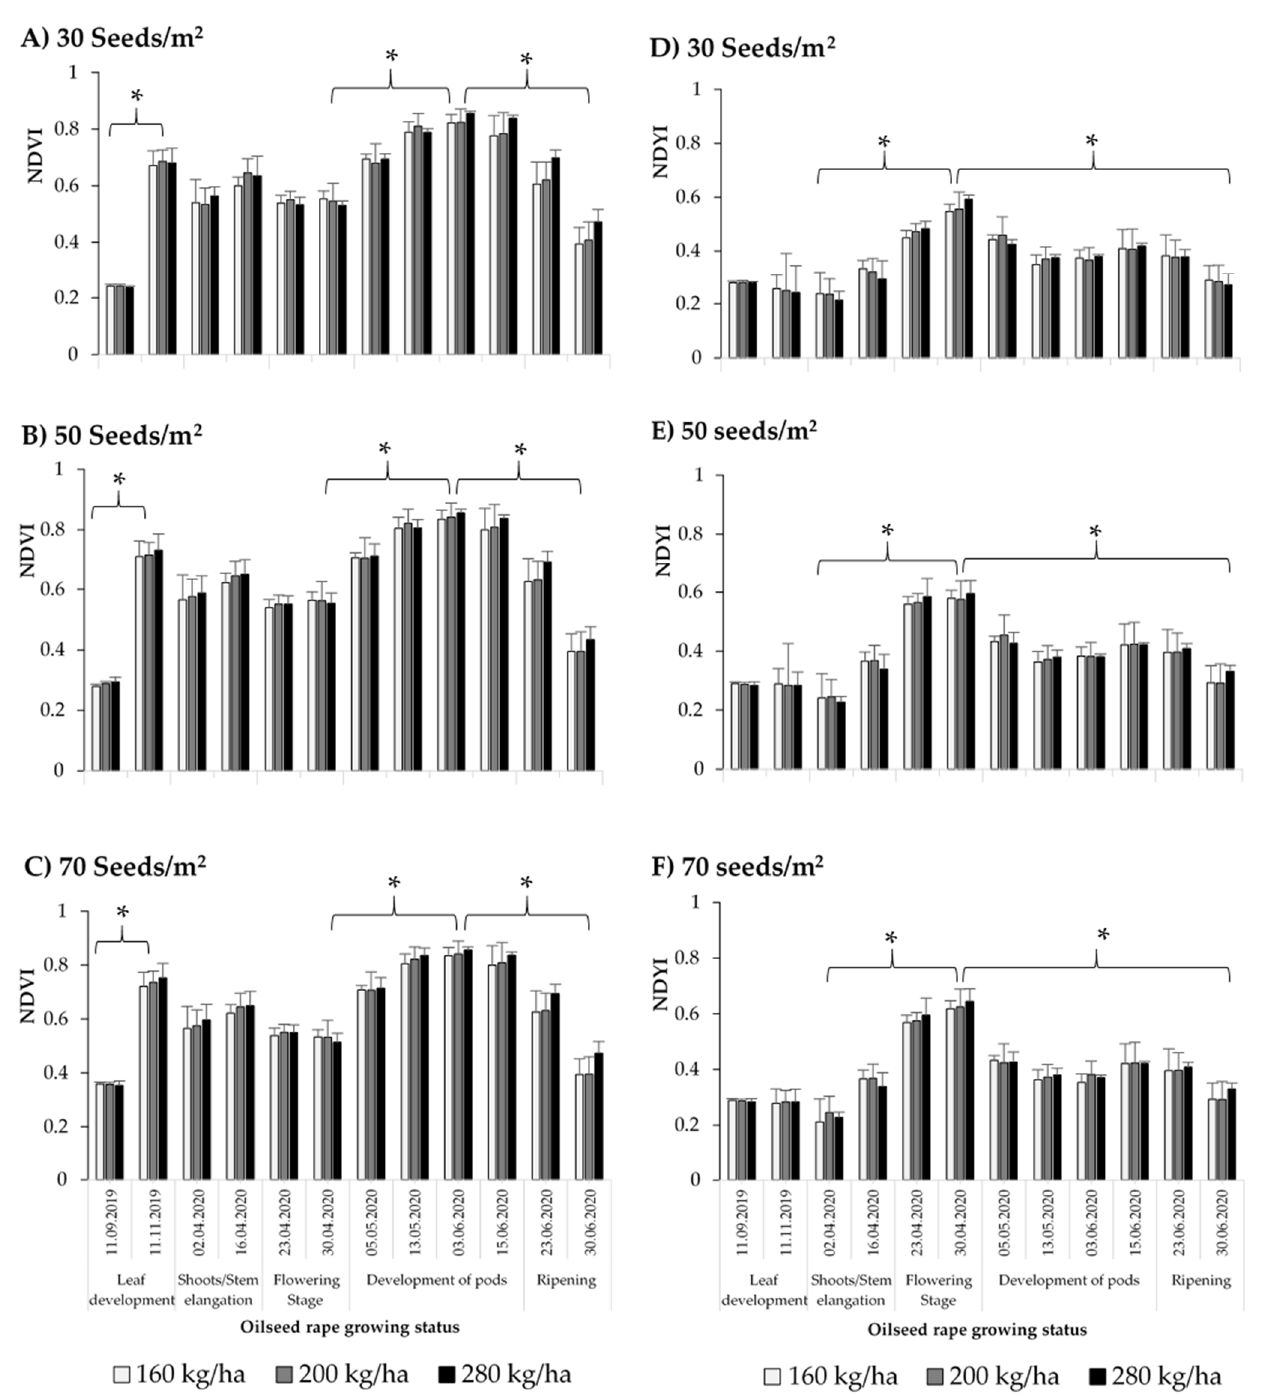
Figure 3. Monitoring winter oilseed rape growth status, from seeding to ripening stages, by normal- ized difference vegetation index (NDVI; A – C ) and normalized difference yellowness index (NDYI; D – F ) derived from UAV-based RGB imaging. A field trial (sown on 28 August 2019) with different seed densities (30, 50, and 70 seeds per m 2 ) and three nitrogen rates (160, 200, and 280 kg [N] ha − 1 ) was conducted in 2019–2020 in Salzdahlum, Germany. In this growing season, 12 flight campaigns were operated at approximately 25 m altitude. The NDVI and NDYI values for each plot (n = 4 replicates per treatment) were calculated from the reflectance at RGB and NIR bands’ wavelengths pictured in a reconstructed and segmented ortho-mosaic. Error bars indicate the standard deviation between replicates. *: Differences between growth stages are significant ( p ≤ 0.05).